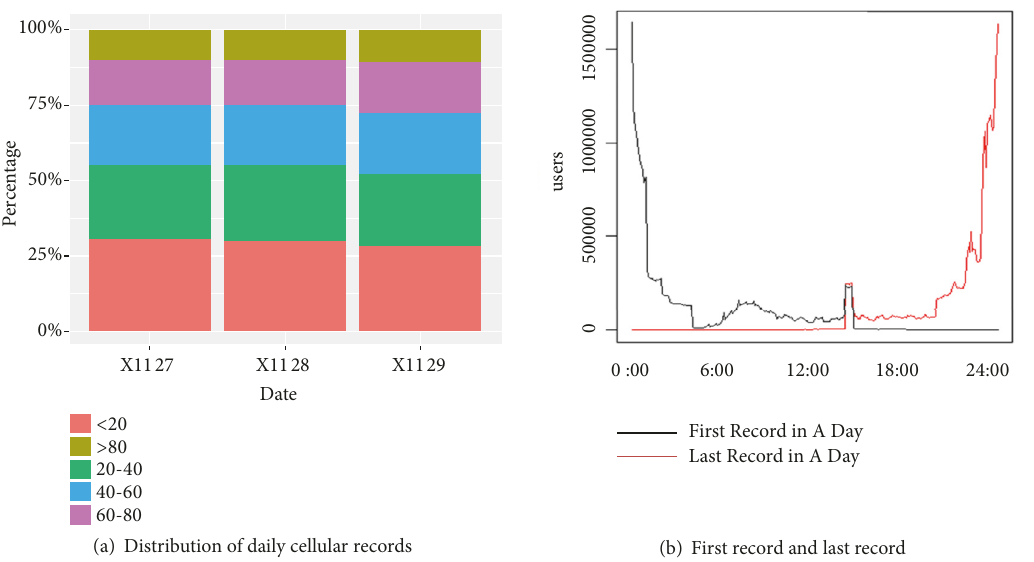
Figure 2: Preliminary of cellular data temporal